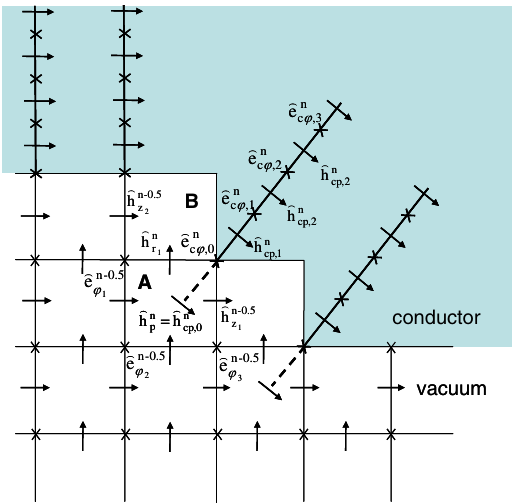
FIG. 6. The grid in the vacuum with 1D conductive lines in the metal (monopole case).